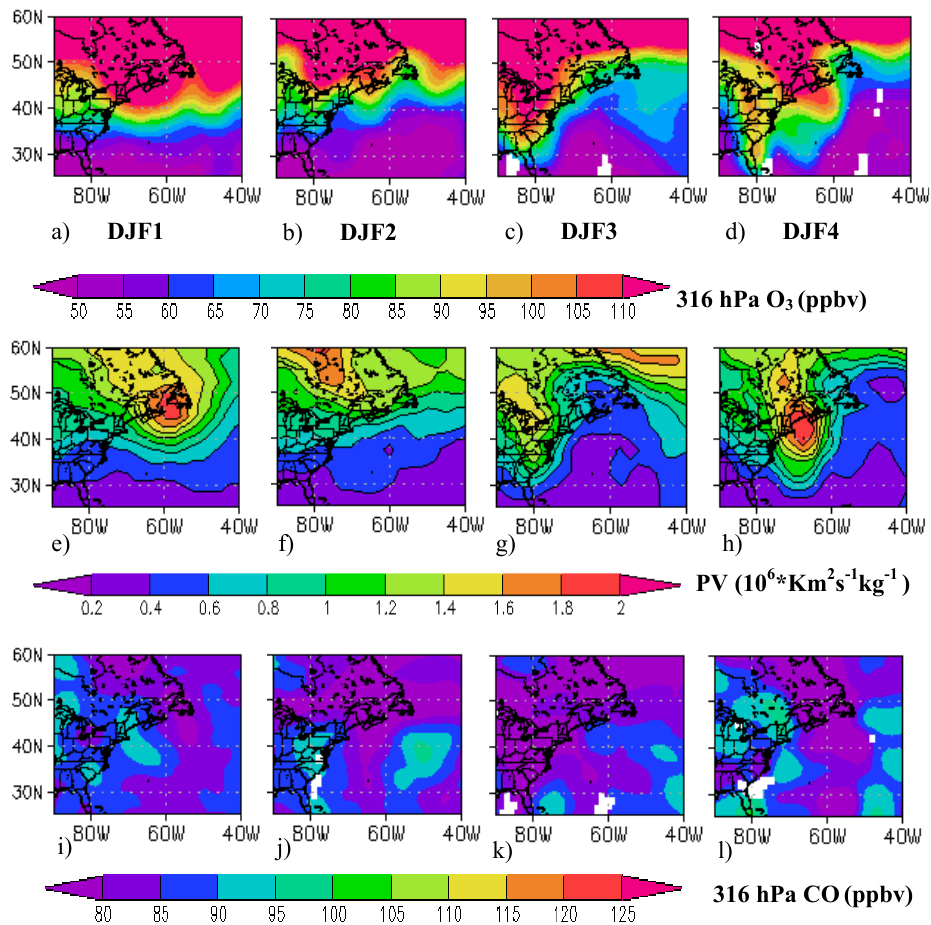
Fig. 11. The TES 316hPa O 3 (ppbv) composites for DJF1-DJF4 (a–d) , corresponding NNRA potential vorticity (10 6 *Km 2 s − 1 kg − 1 ) interpolated to 400hPa (e–h) , and corresponding TES 316hPa CO composites (i–l)